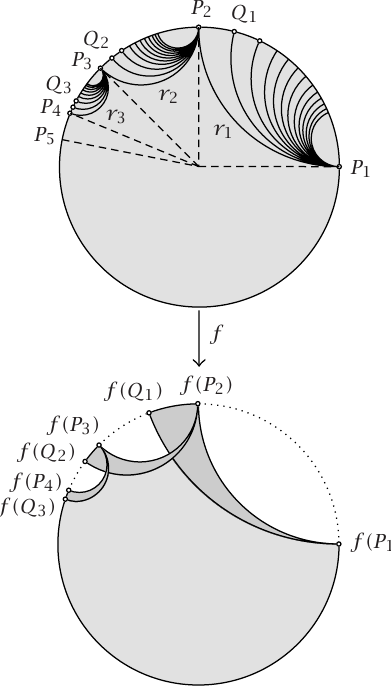
Figure 3.2. Hyperbolic folding with 3